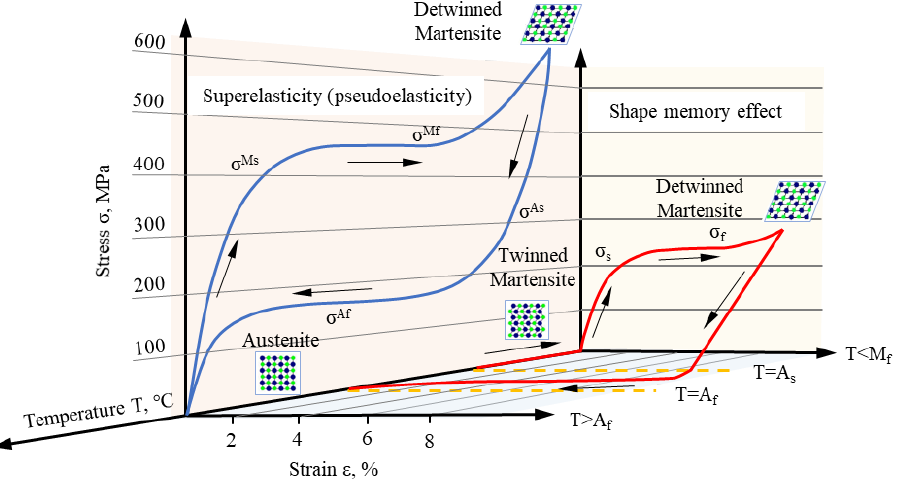
Figure 1. Superelasticity and shape memory effect curves of Ni-Ti shape memory alloys (adapted from [21,22]).